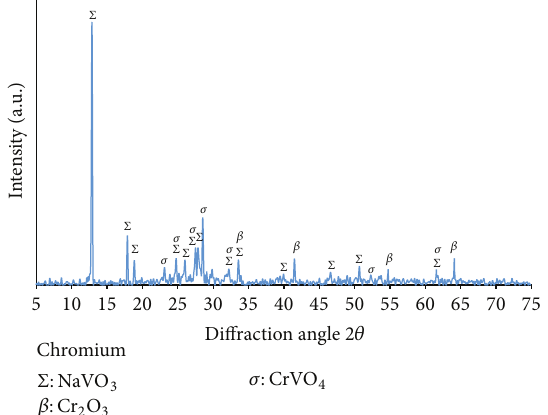
Figure 3: X-ray diffraction results of corrosion products of chromium exposed to NaVO 3 at 700 ∘ C during 100